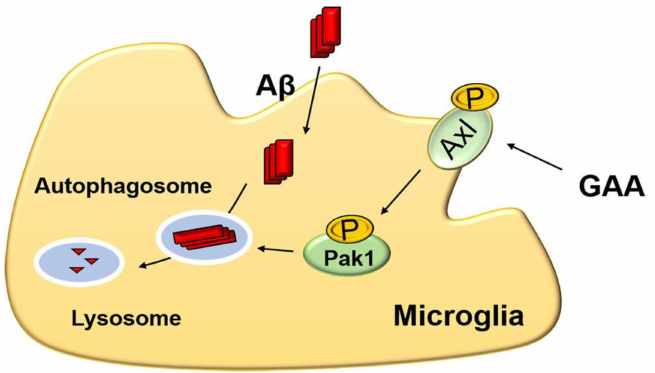
Figure 5. Proposed mechanism of GAA-mediated A β clearance in